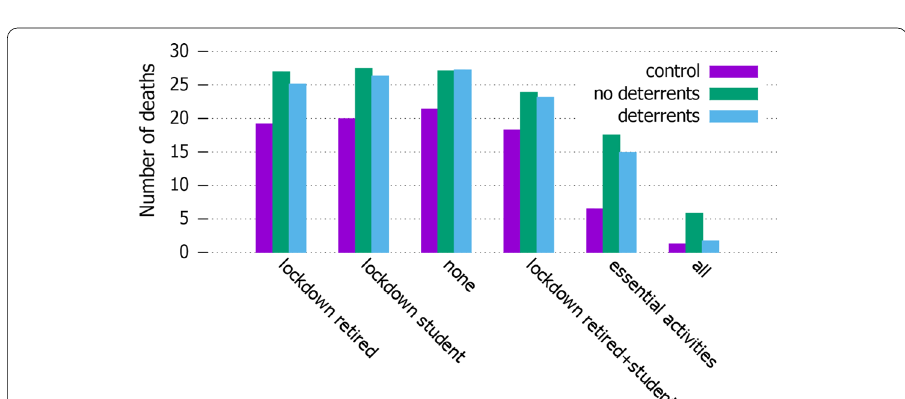
Fig. 12 Deaths Number of deaths in the different